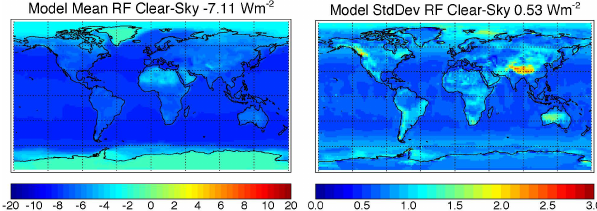
Fig. 5. Annual mean short-wave clear-sky top-of-atmosphere ra- diative forcing (RF) between experiments with AOD=0.2 and AOD=0.0 distributed over the lowest two kilometers, holding SSA=1.0 and ANG=1.0 constant